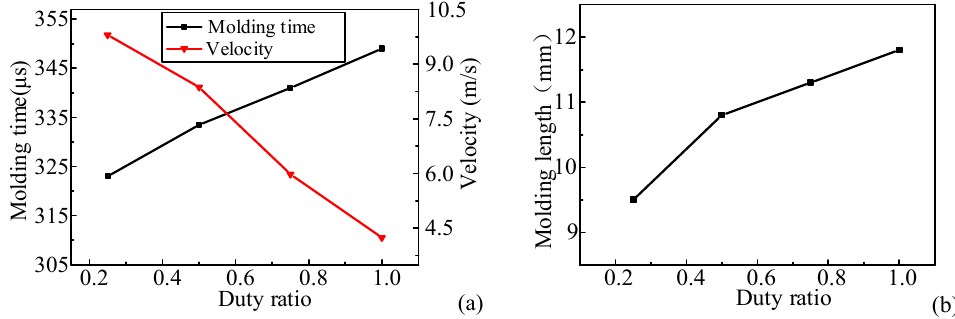
Figure 11. ( a ) The changing curves of molding time and velocity; ( b ) the relationship curve of molding length and duty ratio.